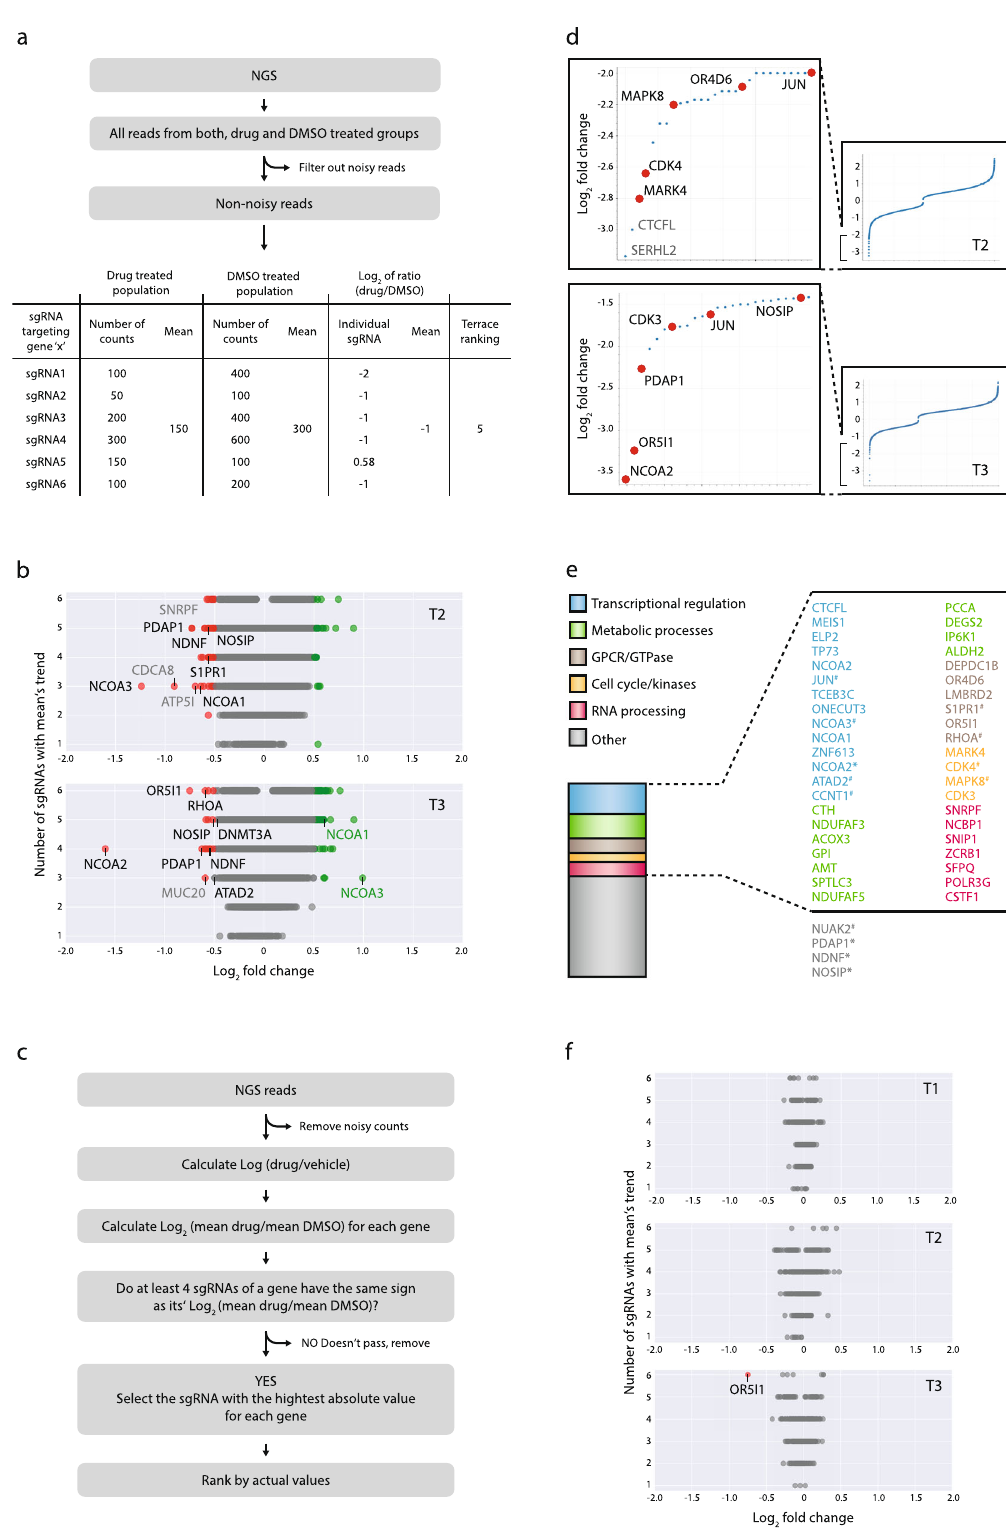
Fig. 2 Two strategies, terrace ranking and decisive ranking of CRISPR-screen outputs (DRACO) fi ltration were applied for the selection of candidate genes. a Terrace ranking selection outline (count numbers are arbitrary and were used only for exampli fi cation purposes). b Top dropped-out genes selected by terrace ranking on terrace plots of time points T2 and T3. c DRACO selection outline. d Top dropped-out genes selected after applying DRACO algorithm-based fi ltration. e Top ~100 selected candidate genes from T2 and T3 were categorizes based on UniProt primary function indicating that ~50% of the selected genes belong to fi ve major biological processes. #Availability of small molecule inhibitor; *appeared in more than one of the four groups (see ( b ) and ( d )). f Terrace plots for OR genes indicate that OR5I1 is the only OR that is outside the “ neutral ”